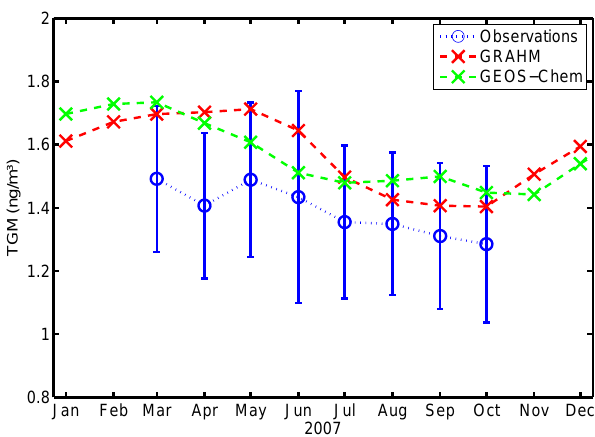
Fig. 6. Monthly means of mercury concentrations measured in Nieuw Nickerie (blue) and simulated by GRAHM (red) and GEOS-Chem (green). Error bars of the observational data represent one standard deviation. The model data are plotted without error bars. Dashed lines are for orientation.